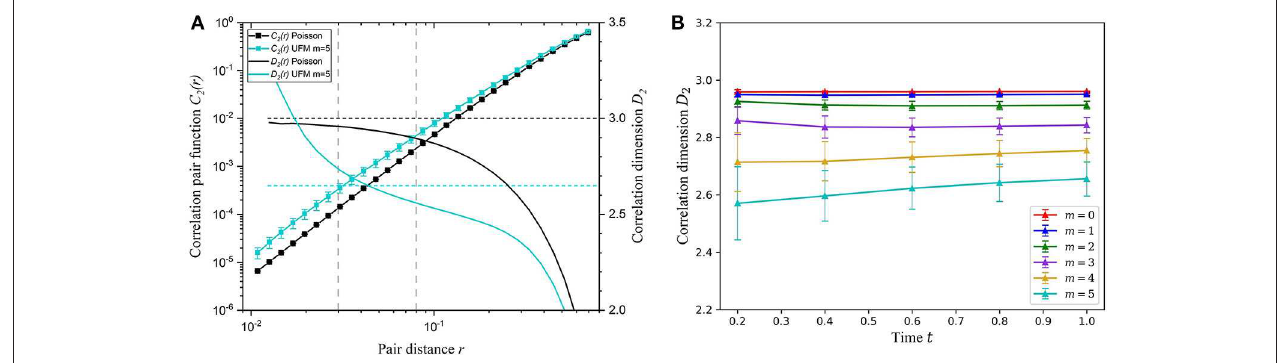
FIGURE 4 | (A) Correlation pair function, and (B) correlation dimension analysis for the Poisson, stress-independent UFM, and stress-driven UFM models.